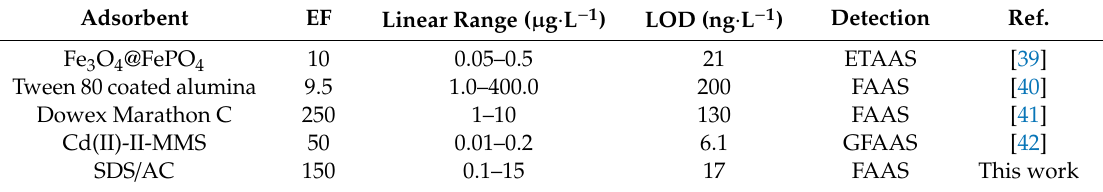
Table4. Comparisonofanalyticalperformancesofthepresentworkwiththosereportedintheliteratures for SPE methods combined with atomic absorption spectrometry for cadmium